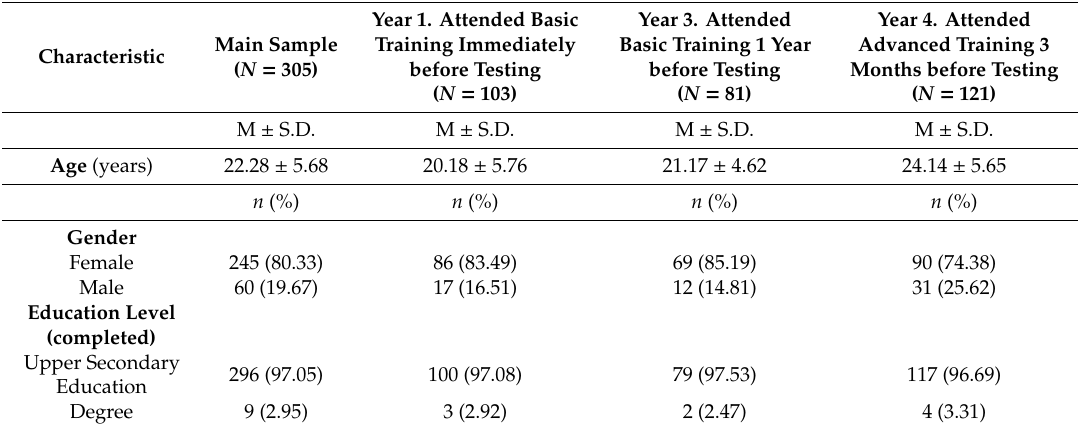
Table 1. Demographic characteristics of the main sample ( N = 305) and known